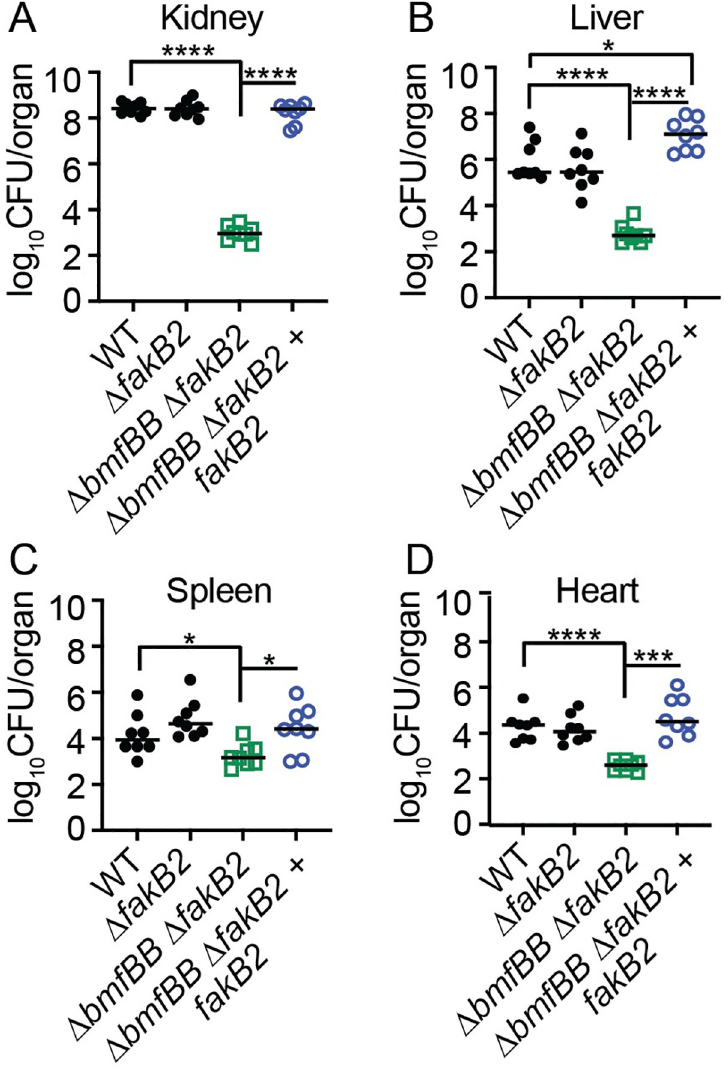
Fig 6. S . aureus bypass of BCFA auxotrophy. (A-D) Bacterial burden (log 10 CFU per organ) recovered from kidney (A), liver (B), spleen (C), and heart (D) 72 hours post-infection with WT, Δ fakB2 , Δ bmfBB Δ fakB2 , and Δ bmfBB Δ fakB2 + fakB2 ( n = 8 per group). Graphs represent combined data from two independent experiments. Statistical significance was determined Kruskal-Wallis test with Dunn’s posttest. � P < 0.05; ��� P < 0.001, ���� P <